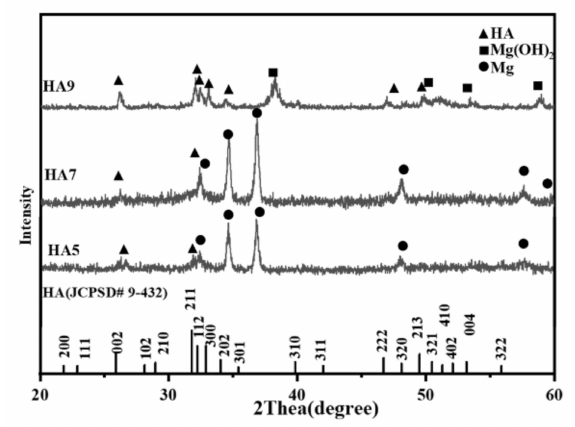
Figure 1. X-ray diffraction (XRD) patterns of hydroxyapatite (HA) coatings obtained at different pH values.